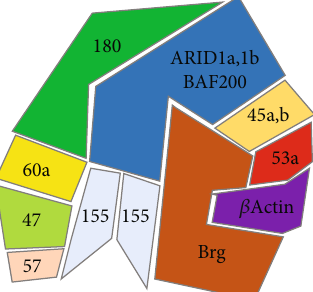
Figure 3: The subunits constituent of the esBAF